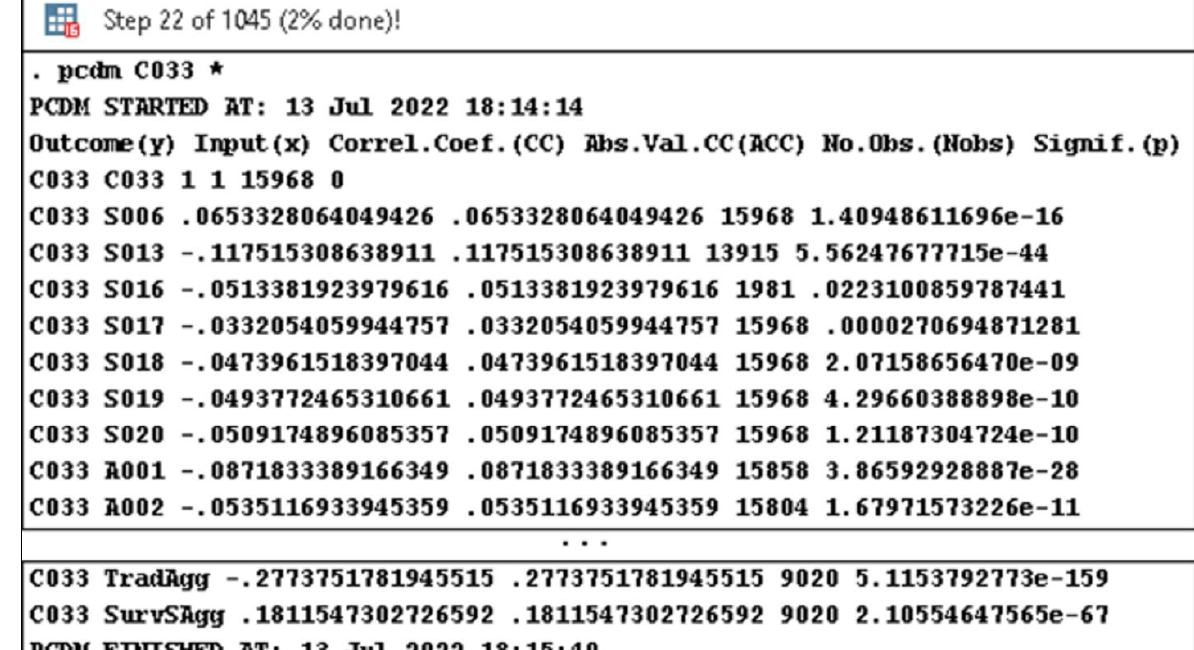
Figure 2. Simple usage scenario involving a single logical processing core (PCDM) with the real-time reporting of execution progress for a 1045 variables dataset (WVS). Notes: The asterisk (*) stands for all variables in the dataset. The first dot (.) is automatically generated by Stata after en- tering the command (pcdm C033 * ) . The subsequent occurrences of dots (PCDM’s feedback in Stata’s console) followed by numerical values indicate zeros (0) followed by their decimal parts (e.g., .065 is actually 0.065 while -.1175 is actually − 0.1175). The “e” followed by the minus (“−”) and a value indicates the E notation corresponding to the scientific one (1.4e-16 is actually 1.4 × 10 −16 ).